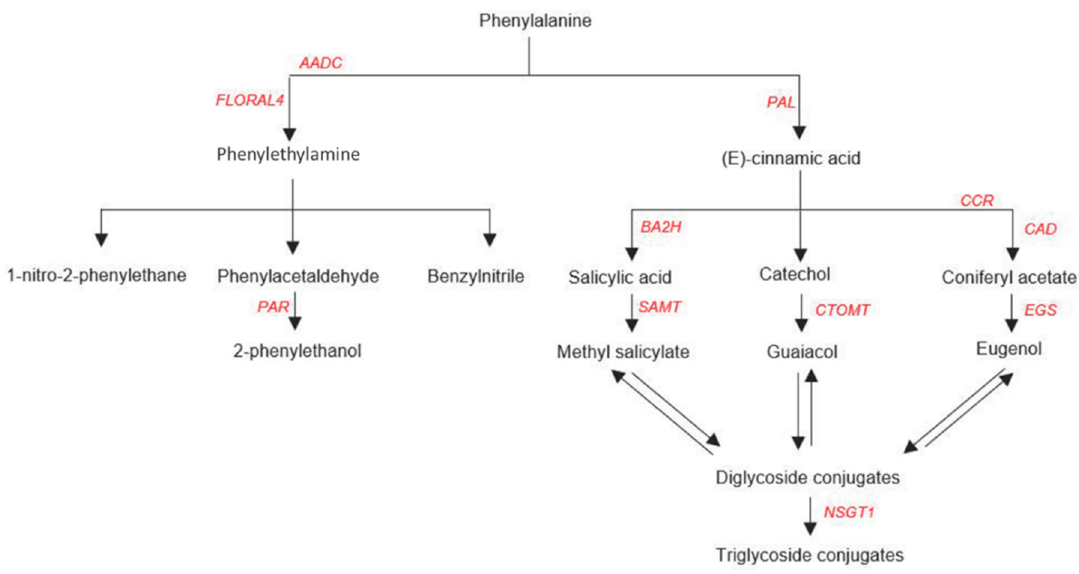
Figure 5. Overview of the phenolic and phenylpropanoid VOCs pathways, adapted from [11].